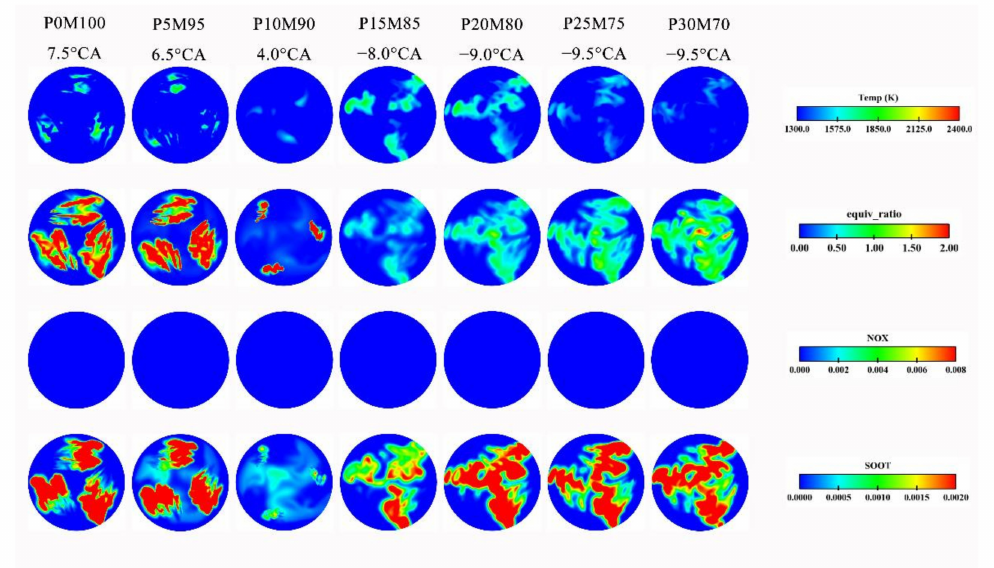
Figure 10. Impact of pilot injection mass ratio on the distribution of temperature, fuel-air equivalence ratio, NOx formation, and soot formation at the moment of 10% accumulative heat release (q10) for various injection